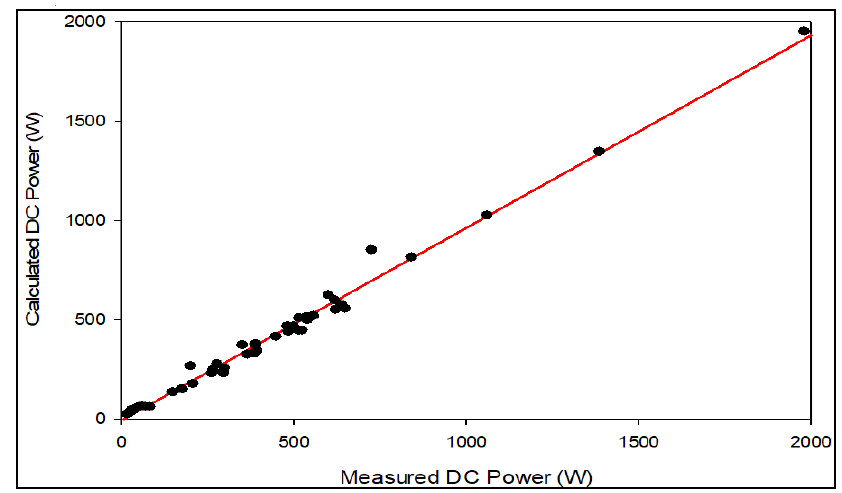
Figure 4. Measured versus calculated DC power.